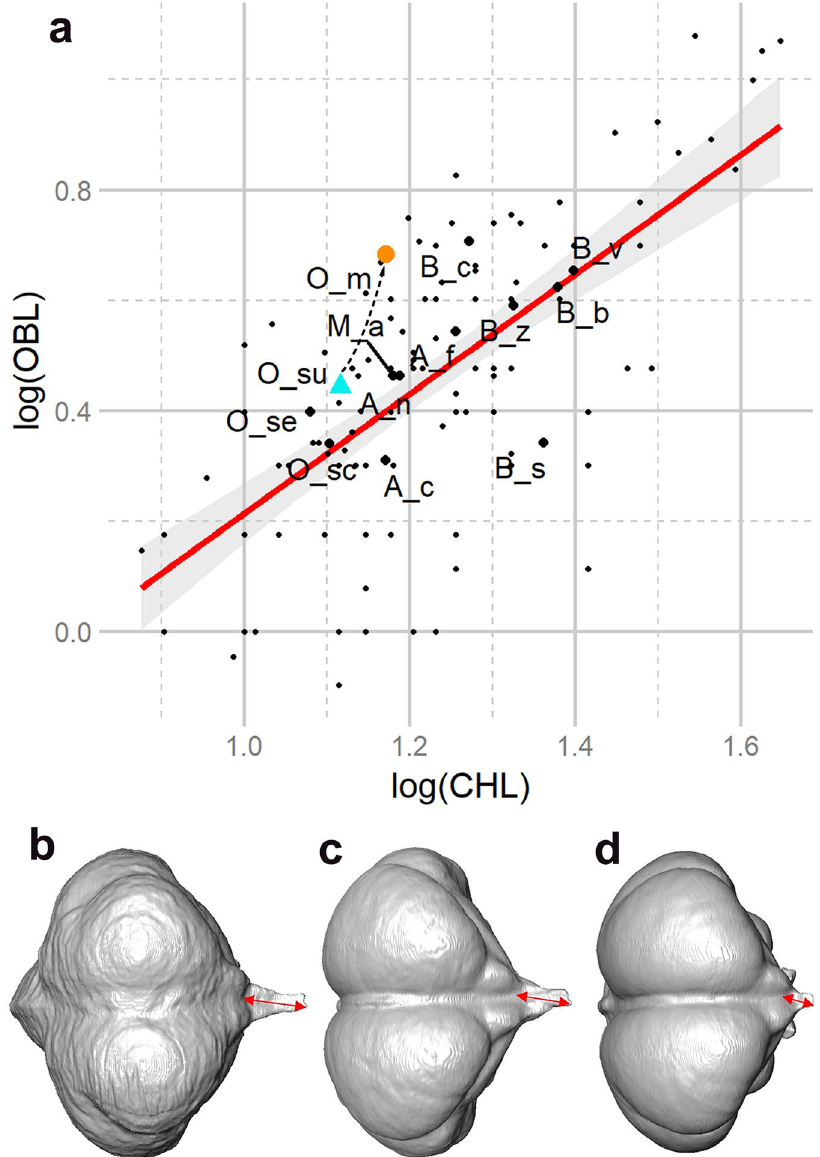
Figure 4. ( a ) Scatter plot of LOG olfactory bulb length (OBL) to LOG cerebral hemisphere length (CHL) (as in Ref. 22 ), with the ten extant owls (large black dots; green–blue triangle for O. sunia ) and the Rodrigues owl O. murivorus (orange circle), together with published bird data 18,22 . The Rodrigues owl shows the highest olfactory bulb ratio among strigids, and one of the highests among all birds. Abbreviations additional to this owl’s study (two owls from Ref. 22 ): B.v., Bubo virginianus ; Asio f., Asio flammeus. Linear regression line is Y/X type (r 2 = 0.48). Slope = 1.1. The translucid grey zone represents a 95% confidence interval around the regression. Bubo scandiacus is positioned at the opposite (with lowest olfactory bulb ratio among strigids). Dashed arrow symbolizes evolutionary trajectory from O. sunia to O. murivorus . ( b – d ) Cranial endocasts of O. murivorus ( b ), O. sunia ( c ) and A. cunicularia ( d ). The red arrows show the length of the olfactory bulb (measured as in Ref. 22 ). Not to